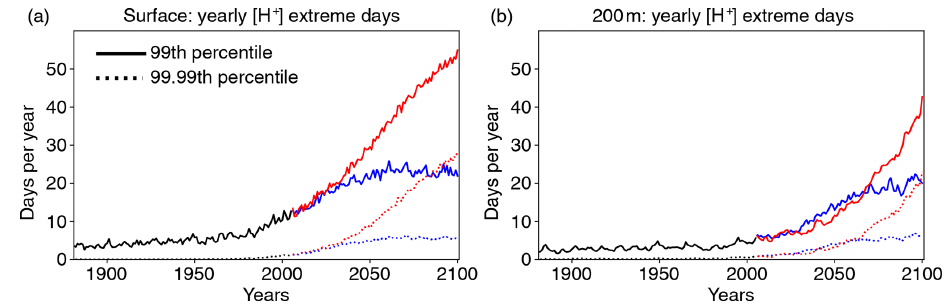
Figure 12. Globally averaged number of yearly extreme days for [H + ] over the historical (black lines), RCP2.6 (blue), and RCP8.5 (red) simulations for the preindustrial 99th (solid lines) and 99.99th percentile (dotted lines) at the surface (a) and 200m (b) . The extreme events are defined with respect to shifting